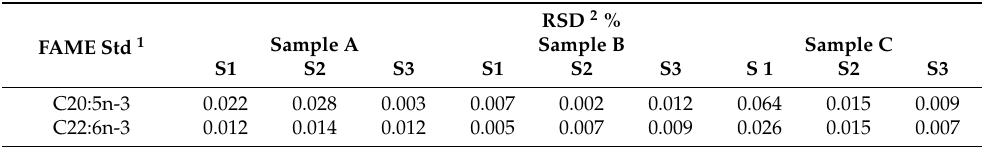
Table 2. Precision (RSD%) under the repeatable condition of spiking 50 uL concentration of EPA and DHA standards in three types of cooked fish intraday.